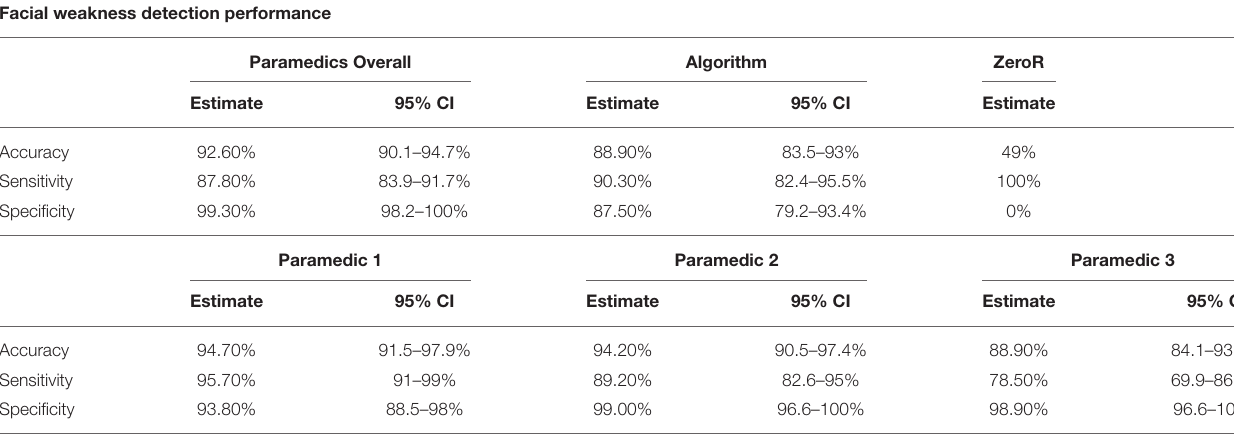
TABLE 1 | Performance metrics of the correct identification of facial weakness and its laterality among all raters. Facial weakness detection performance